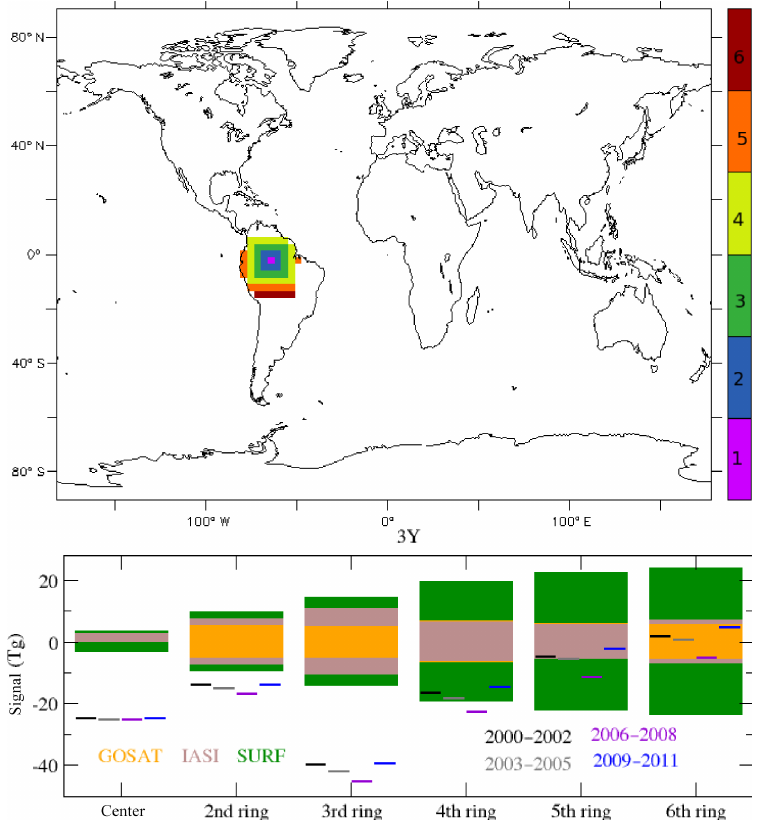
Figure 9. Impact of spatial aggregation in Amazonia on noise (bars) and signal (box plots with median, 25 and 75%) over 3-year time windows, from a unique pixel to larger rings around it. Detection is achieved when the signal is larger than the noise, i.e., for all the occurrences which lay outside the matching colored